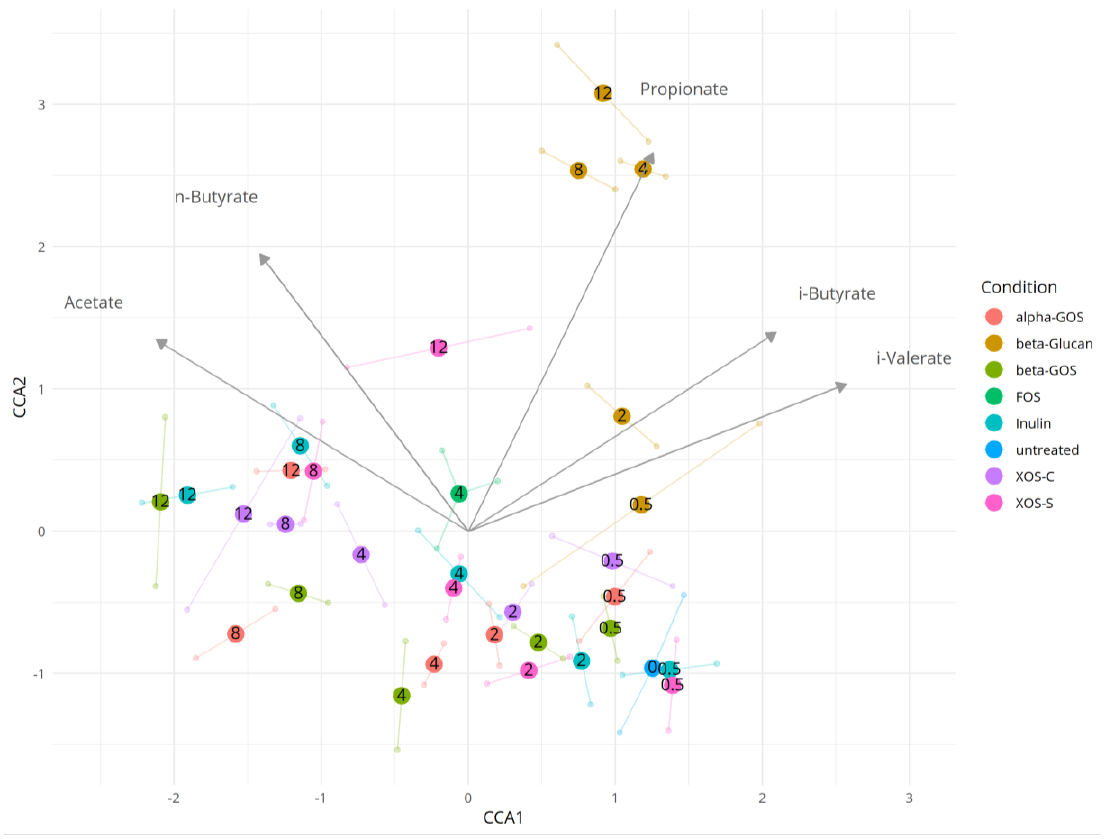
Figure 5. Relationship between the composition of the microbiota and the levels of short-chain fatty acids (SCFAs), using correspondence analysis. The larger dots represent microbiome composition and show the centroid values for each of the sets of duplicate samples. Arrows represent the direction of the association of microbiome composition with specific SCFA levels.